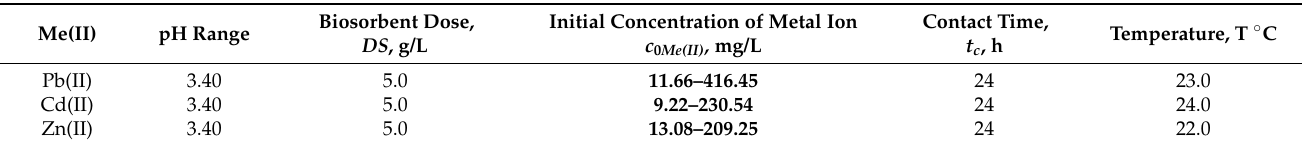
Table 4. Values of working parameters used in the experimental study of the influence of the initial concentration of the metal ions on the biosorption